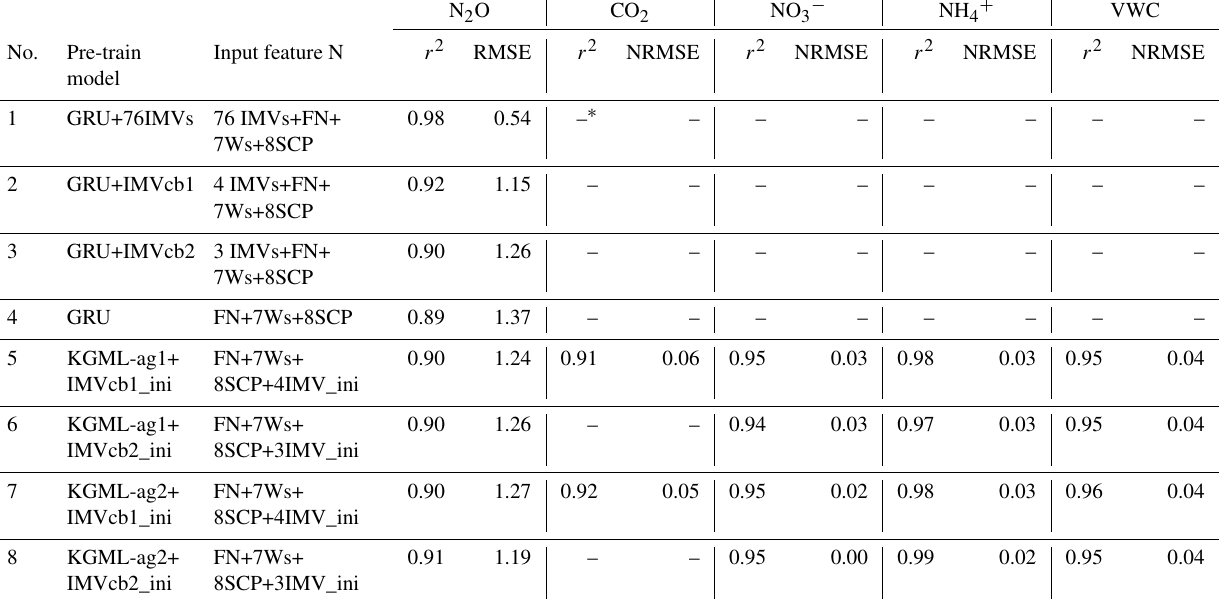
Table 1. Pre-train results for different model and IMV combinations using ecosys synthetic data. Only the performance from testing datasets (synthetic data from 19 counties) was presented.